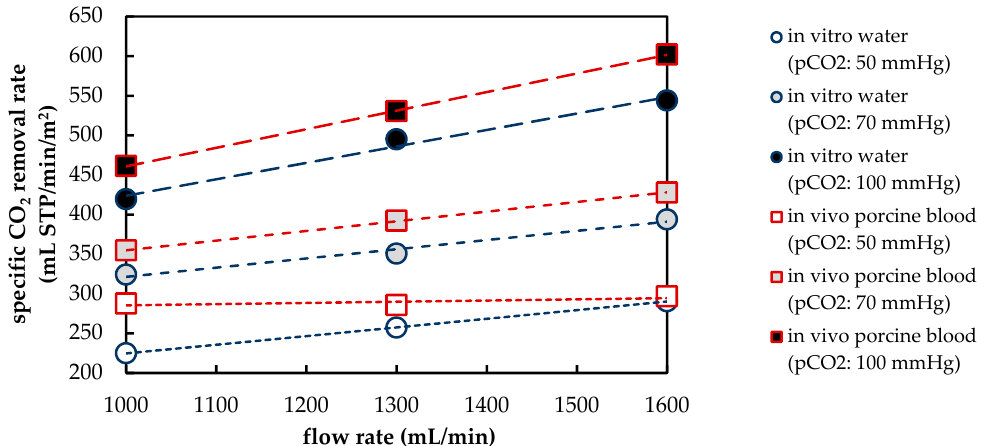
Figure 9. Comparison of experimentally determined CO 2 removal. Red squares: in vivo studies with porcine blood; blue circles: in vitro studies with water.